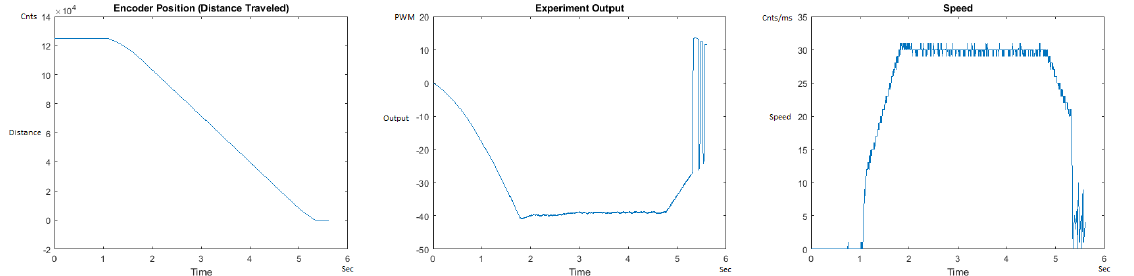
Figure 24. Encoder position, output and speed plots for PID++ DOWN operation— Vmax 30 cnts/ms, Adesired 0.015 cnts/ms 2 —1 Kg.